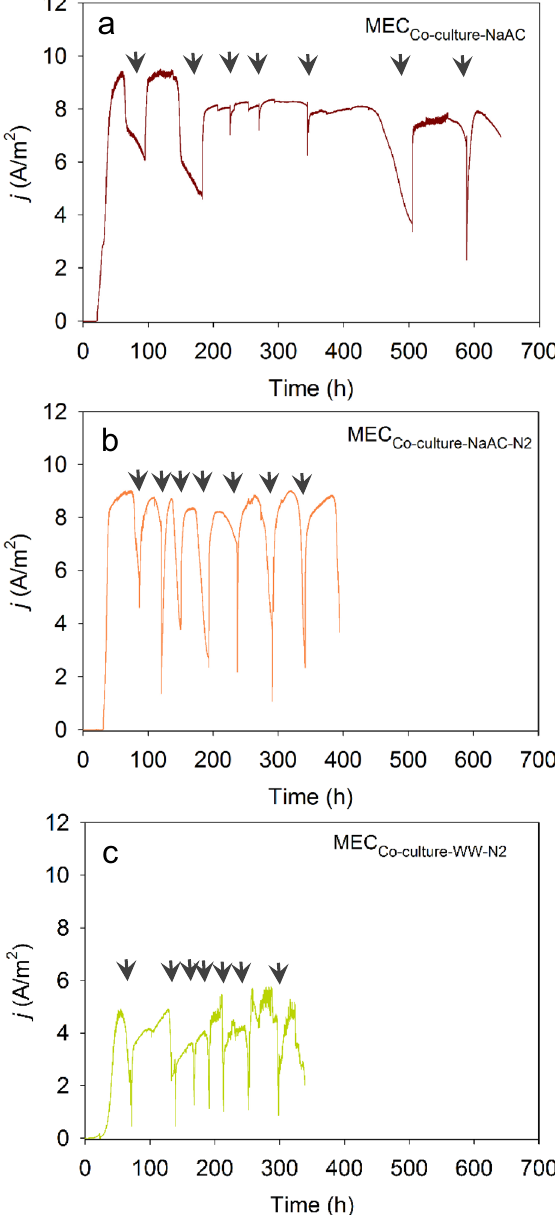
Fig. 3 Amperometric responses for the co-culture MEC reactors. a Reactors fed with synthetic growth medium with sodium acetate as the sole carbon and energy source and operated without N 2 purging in headspace (MEC co-culture-NaAc ), b synthetic growth medium with sodium acetate as the sole carbon and energy source and operated with N 2 purging in headspace (MEC co-culture-NaAc-N2 ), and c domestic wastewater and operated with N 2 purging in headspace (MEC co-culture-WW-N2 ). The current densities represent the average of duplicate MEC reactors. Arrows indicates the change of feed. The fi rst two batches of MEC co-culture-NaAc and MEC co-culture-NaAc-N2 reactors were operated with 10mM acetate containing growth medium (COD equivalent of 600 mg/L), and the remainder of the batches were operated with 6 mM acetate (COD equivalent of 400mg/ L). The fi rst two batches of MEC co-culture-WW-N2 reactors were operated with glucose-supplemented domestic wastewater (COD equivalent of 600mg/L), and the remainder of the batches were operated with glucose-supplemented domestic wastewater at a COD equivalent of